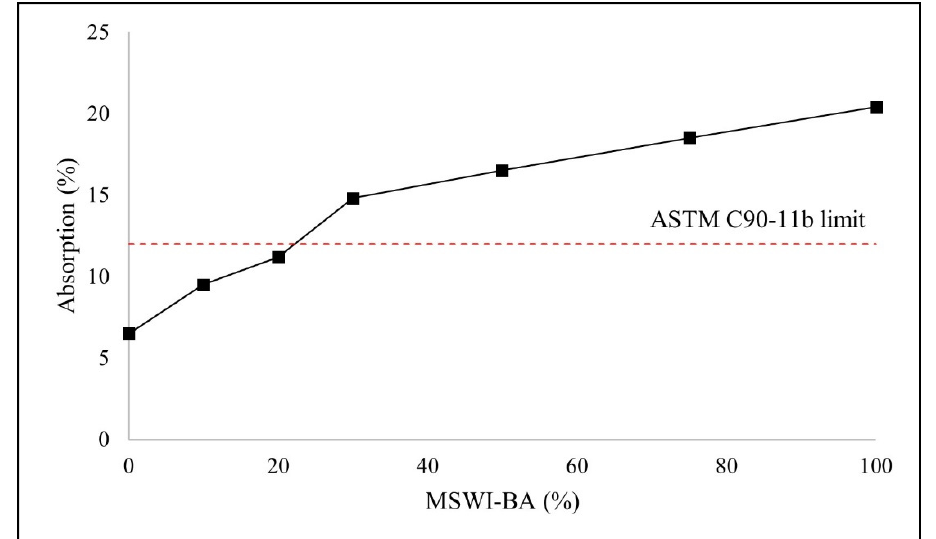
Figure 7. Water absorption of concrete masonry blocks, redrawn from [91].